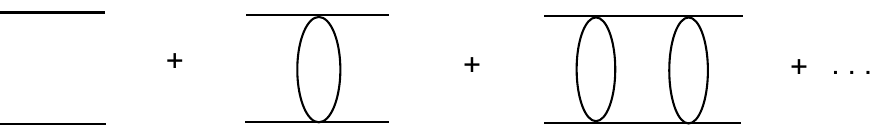
Figure 3. The four-point function is a sum of ladder